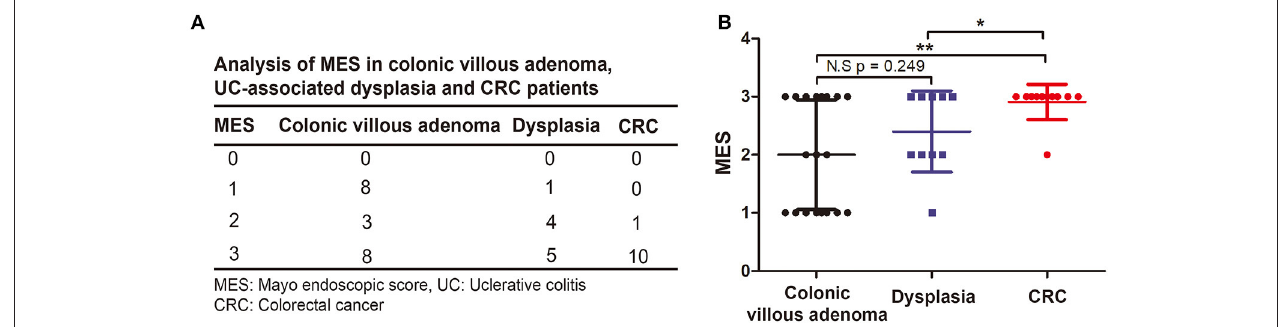
FIGURE 3 | Comparison the association between MES and degree of malignancy. (A) Descriptive analysis of the distribution of MES in colonic villous adenoma, UC-associated dysplasia and CRC. (B) Two-sample Student’s t-test was performed to analyze the association between MES and degree of